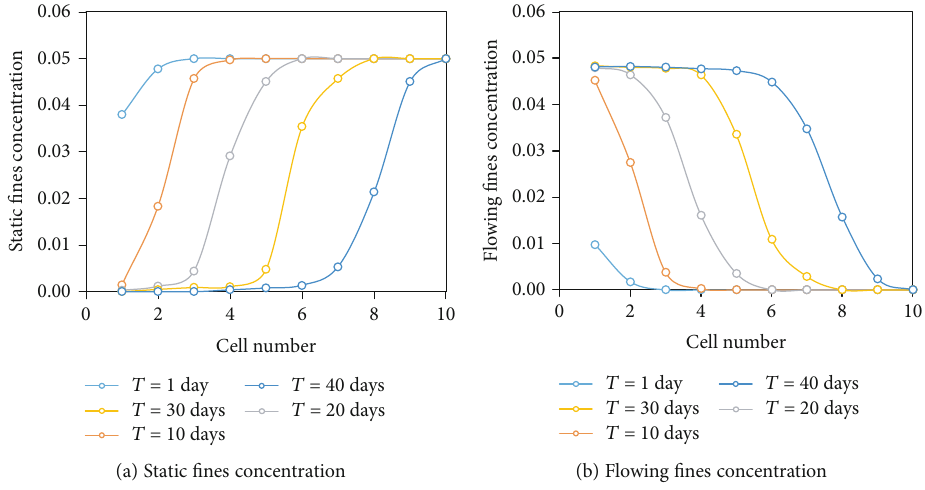
Figure 6: Pro fi le of coal fi nes in the reservoir at 6 m 3